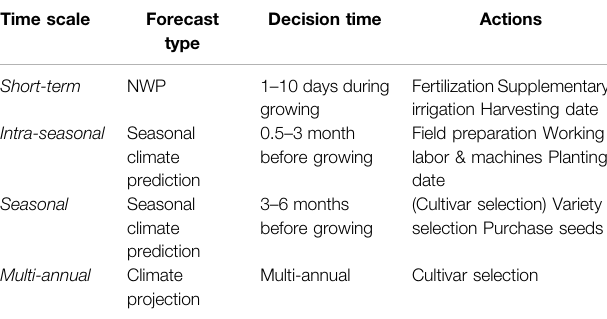
TABLE 1 | Farmers tactical decisions and actions across different time scales based on information obtained from RCM simulations, short-term and long- term climate projections and seasonal- and short-term